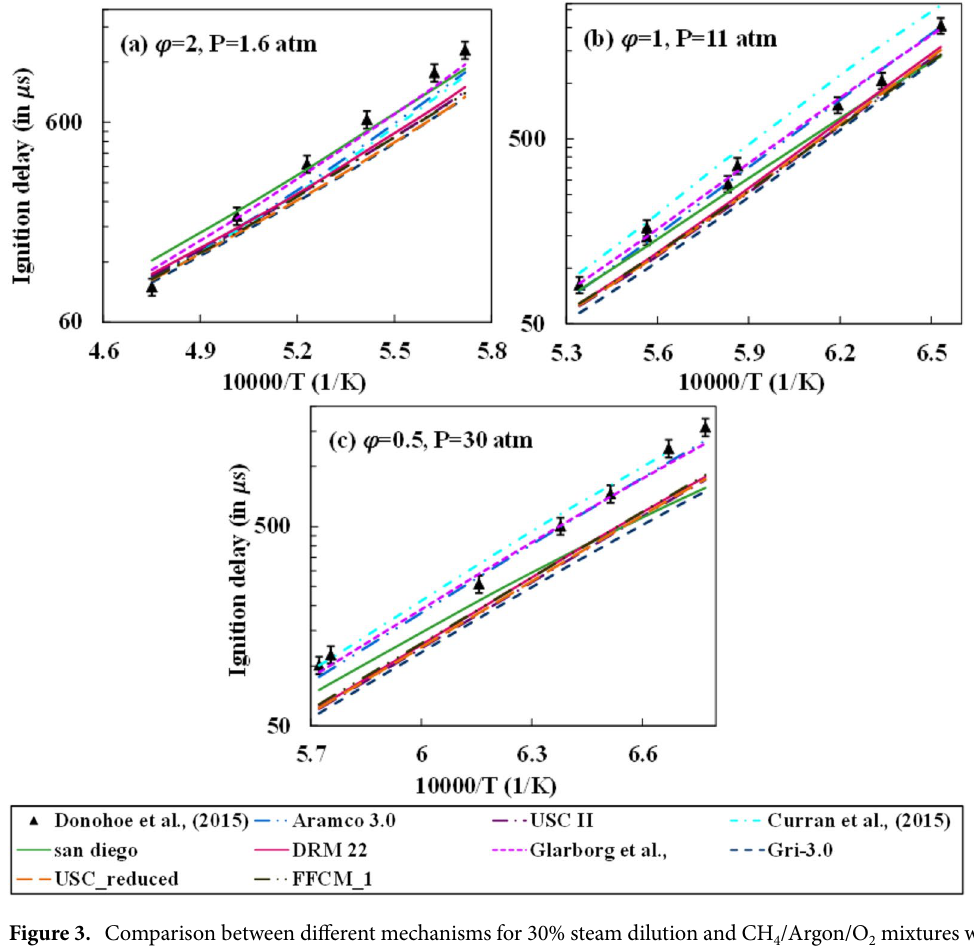
Figure 3. Comparison between different mechanisms for 30% steam dilution and CH 4 /Argon/O 2 mixtures with 98% Argon by volume.